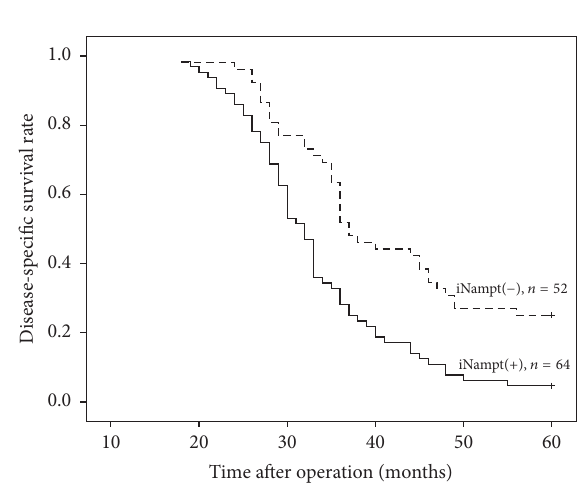
Figure 3: Kaplan-Meier analysis of disease-specific survival of patients with EGA relative to iNampt